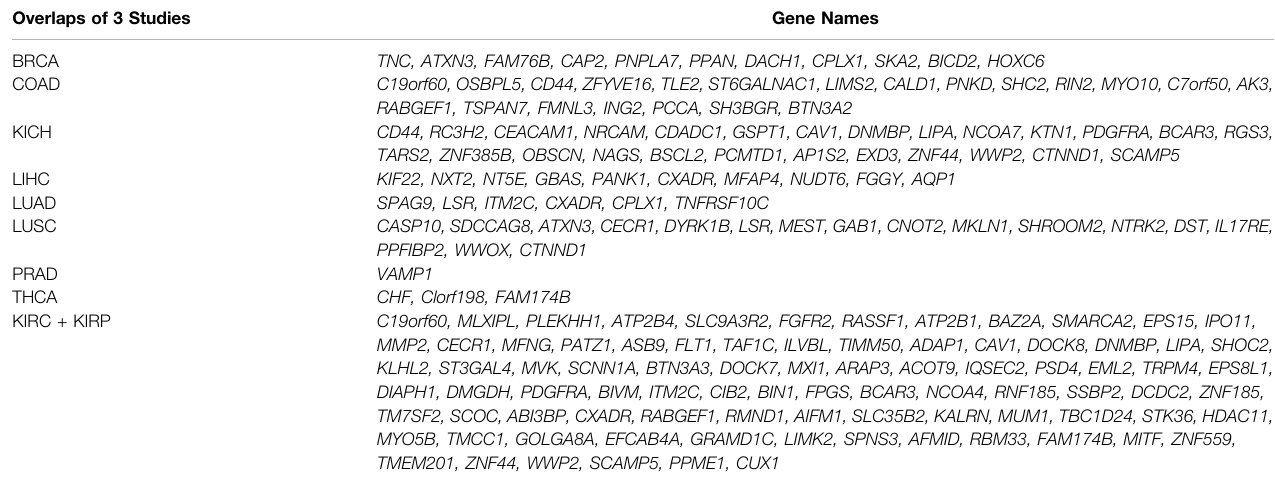
TABLE 3 | List of common genes having an isoform switching event in Climente-González et al. , Kahraman et al. , Vitting-Seerup et al. Overlaps of 3